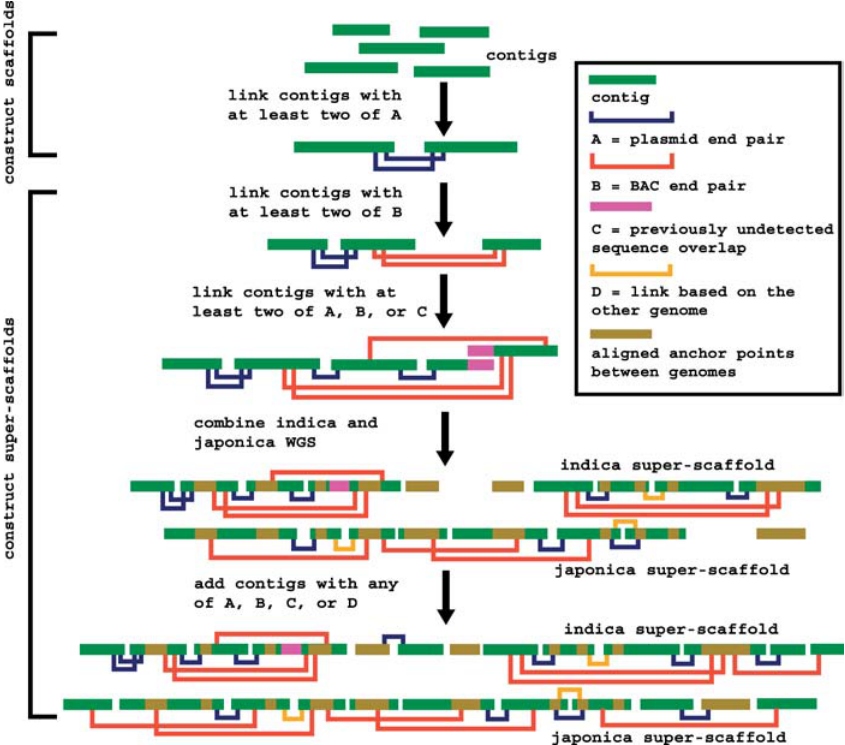
Figure 1. Basic Algorithm for Construction of Scaffolds and Super-Scaffolds We start with the smallest plasmids and progressively work our way up to the largest BACs. Only links with two or more pieces of supporting evidence are made. These include 34,190 ‘‘ anchor points ’’ constructed from a comparison of indica and japonica . Each anchor is a series of high- quality BlastN hits (typically 98.5% identity) put together by a dynamic programming algorithm that allows for small gaps to accommodate the polymorphic intergenic repeats. Typical anchor points contain four BlastN hits at a total size of 9 kb (including gaps). Notice how in the beginning indica and japonica are processed separately, to construct what we called scaffolds. Only at the end do we use data from one subspecies to link scaffolds in the other subspecies, and these are what we called super-scaffolds.